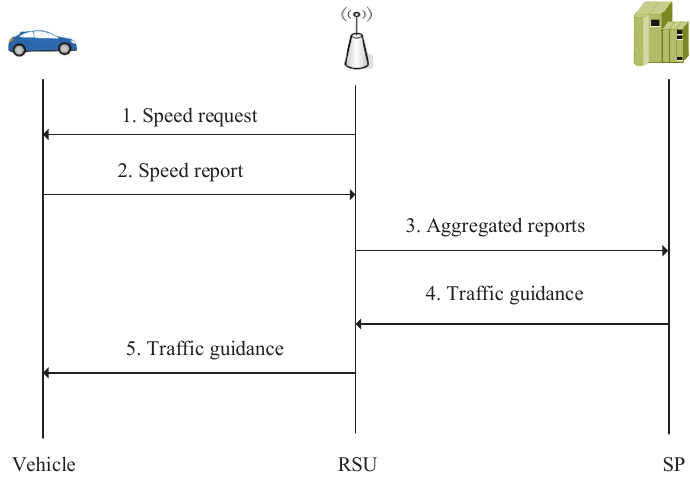
Figure 3. System procedure of